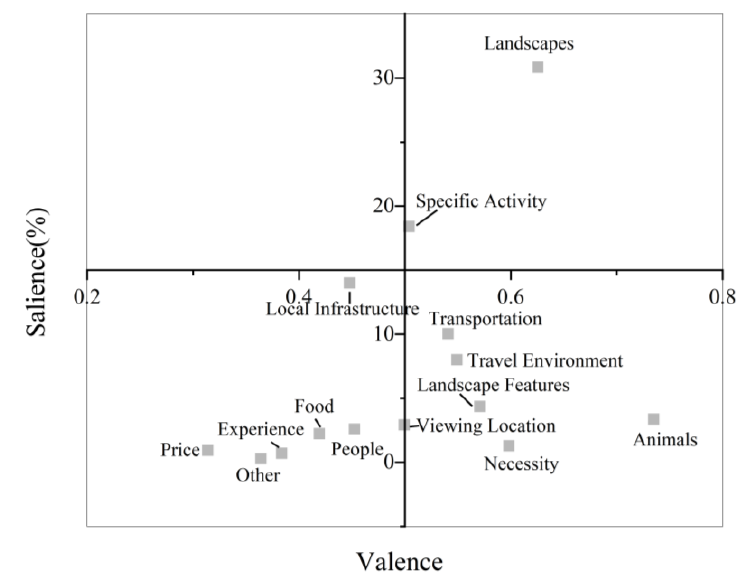
Figure 4. Dimensional salience – valence analysis.